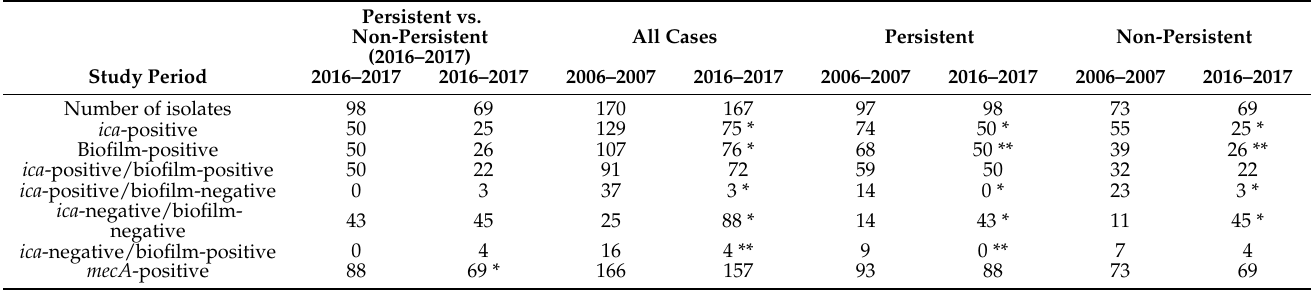
Table 4. Comparison of molecular characteristics of CoNS isolates causing persistent and non- persistent bacteremias throughout the two studied